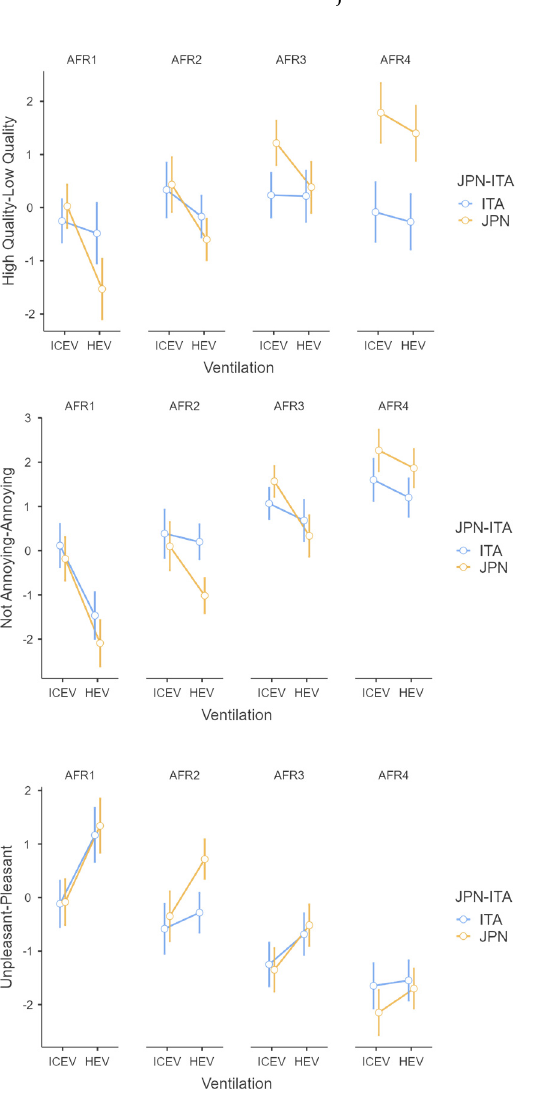
Figure 1. Marginal mean and 95% confidence interval of the Aesthetic dimension items in the Ventilation ( left ) and Air Conditioning ( right ) Functional Modality, for different AFR, Engine Type, and Subject Group.